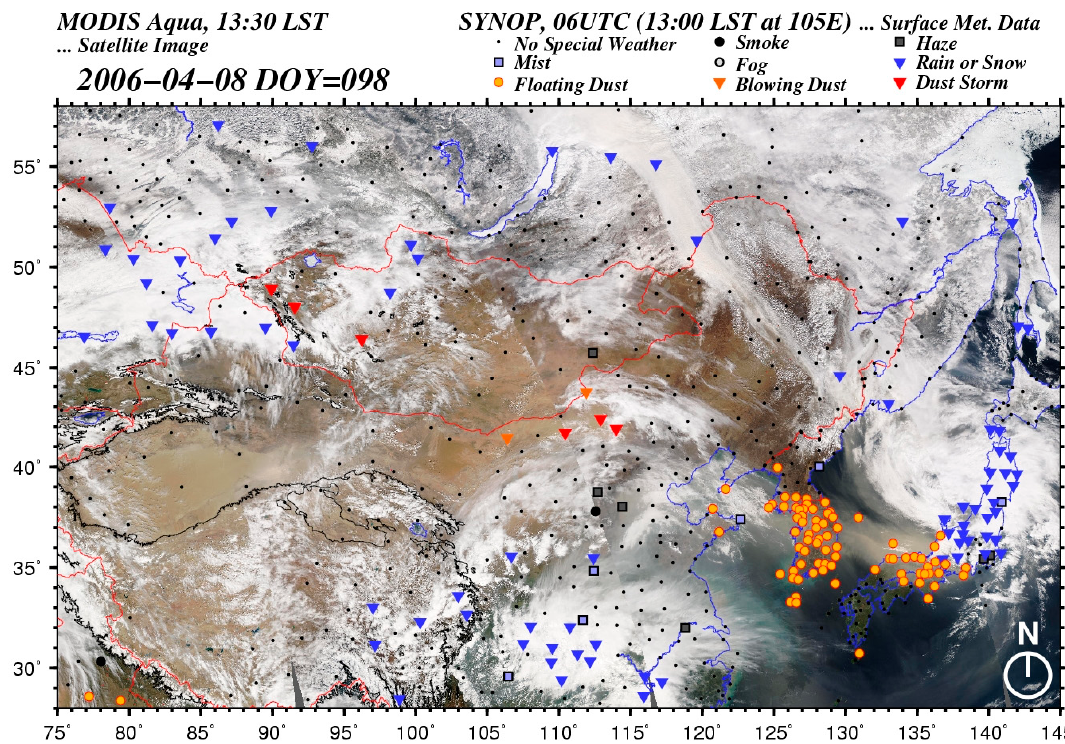
Figure 1. Typical Asian dust event. MODIS: Moderate Resolution Imaging Spectroradiometer true-color images with surface weather conditions on 8 April 2006 (NASA: National Aeronautics and Space Administration/GSFC: Goddard Space Flight Center, Rapid Response).